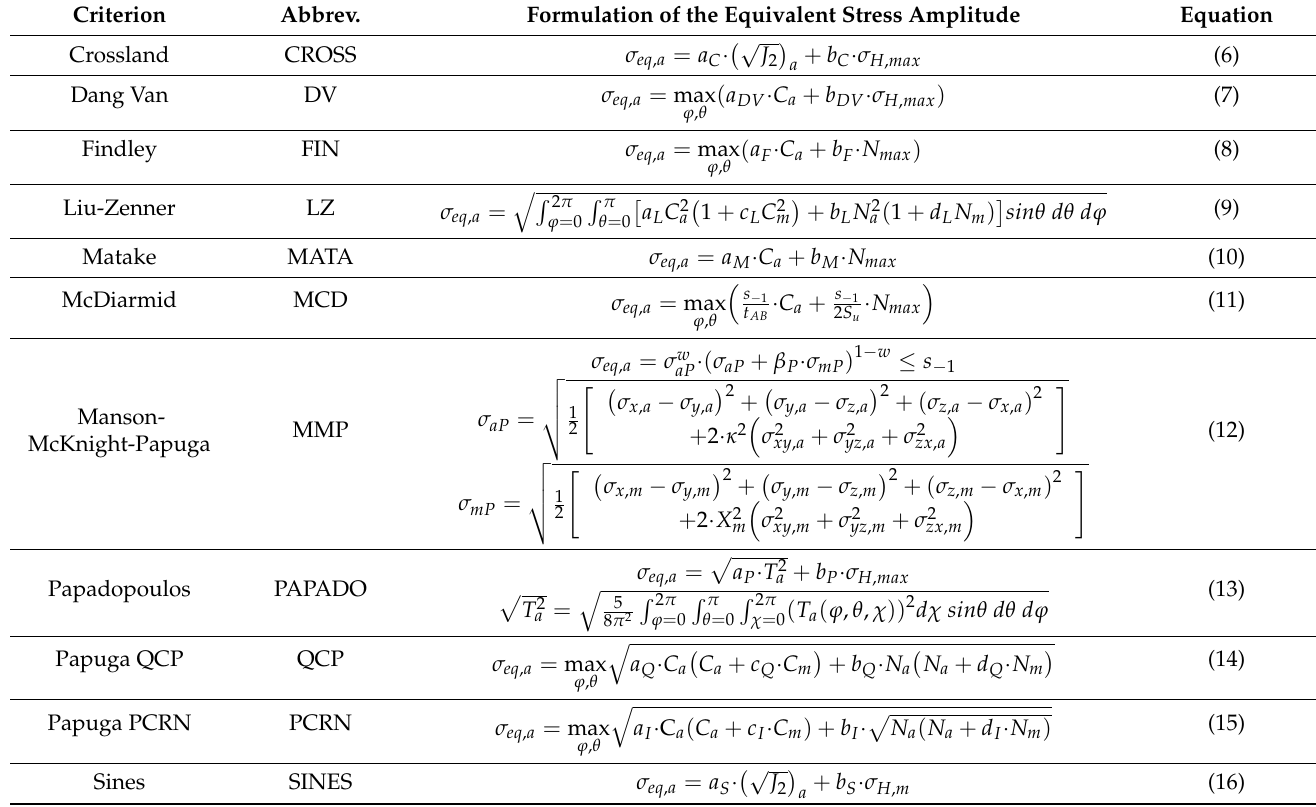
Table 6. Formulas of methods used within the validation program. Parameters used: s − 1 —fatigue strength in fully reversed axial loading, S u —tensile strength, J 2 —second invariant of the deviatoric stress tensor, σ H —hydrostatic stress, C —shear stress on the examined plane, N —normal stress on the examined plane, θ , ϕ —Euler angles defining the orientation of the examined plane, T —resolved shear stress (shear stress projection into a direction described by χ angle), w —Walker’s mean stress effect parameter. Indexes a and m designate the amplitude and mean values, respectively. Formulas for computing a , b , c , d parameters are provided in Table 7. Criterion Abbrev. Formulation of the Equivalent Stress Amplitude